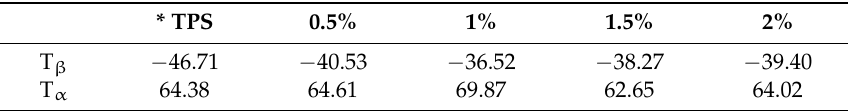
Table 1. Transition temperature of PVAMS/TPS composites prepared at varying PVAMS content (0–2 wt %). (Frequency: 5